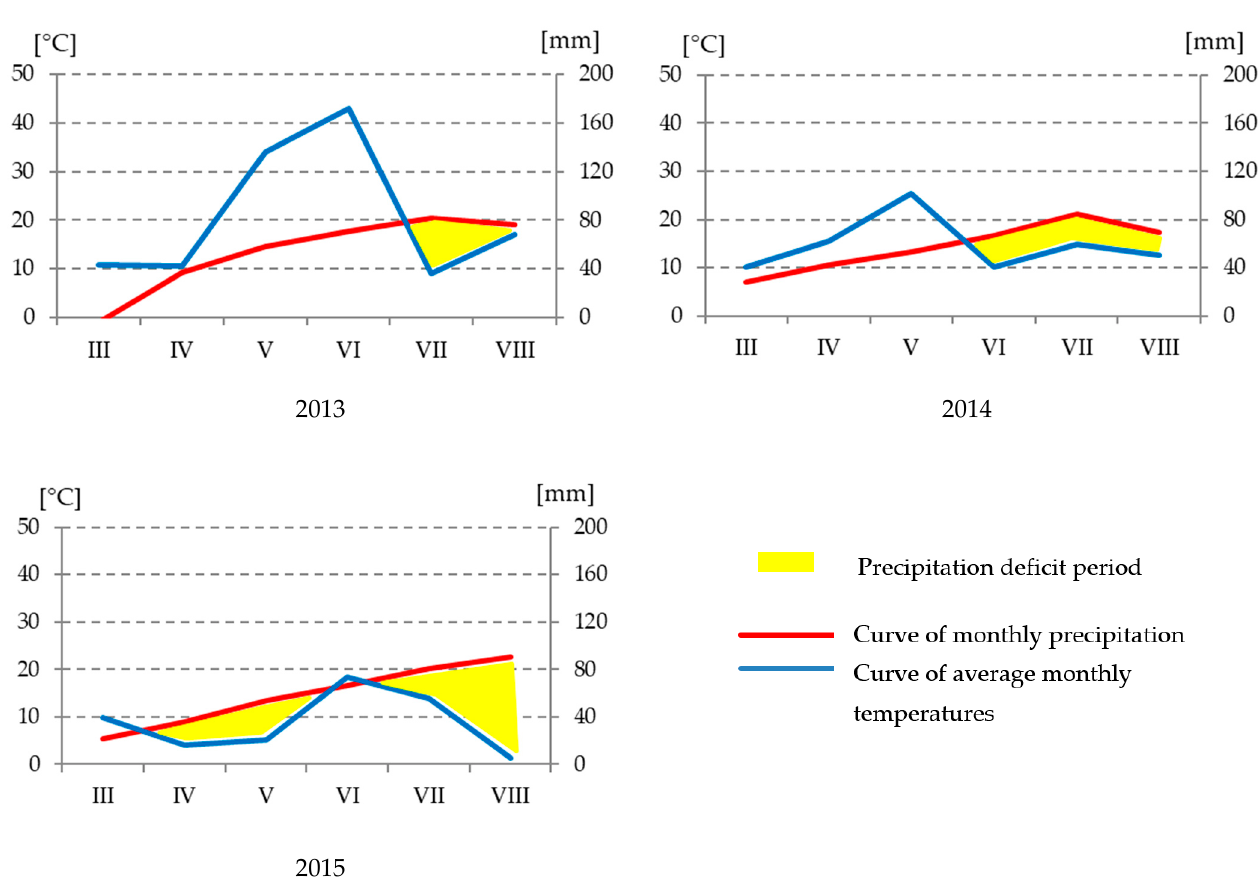
Figure 1. Gaussen–Walter diagrams modified by Łukasiewicz [30] for weather conditions in the years of research.